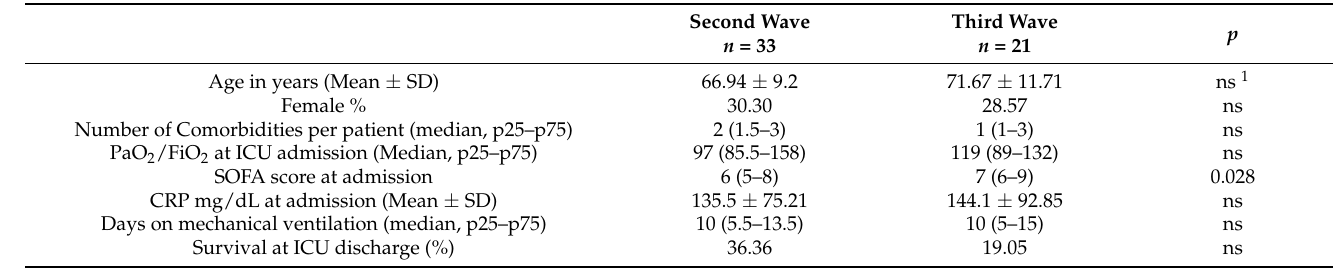
Table 2. Demographic and clinical characteristics of patients included in this study according to their time of admission (second vs. third